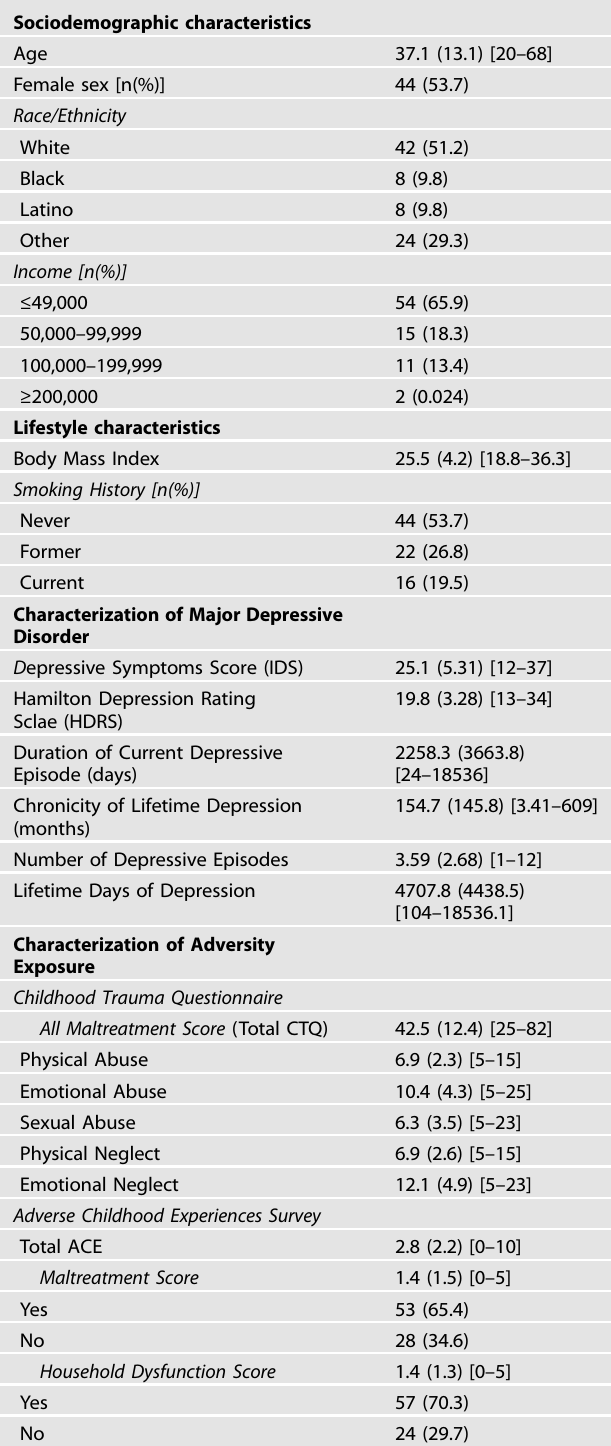
Table 1. Participant